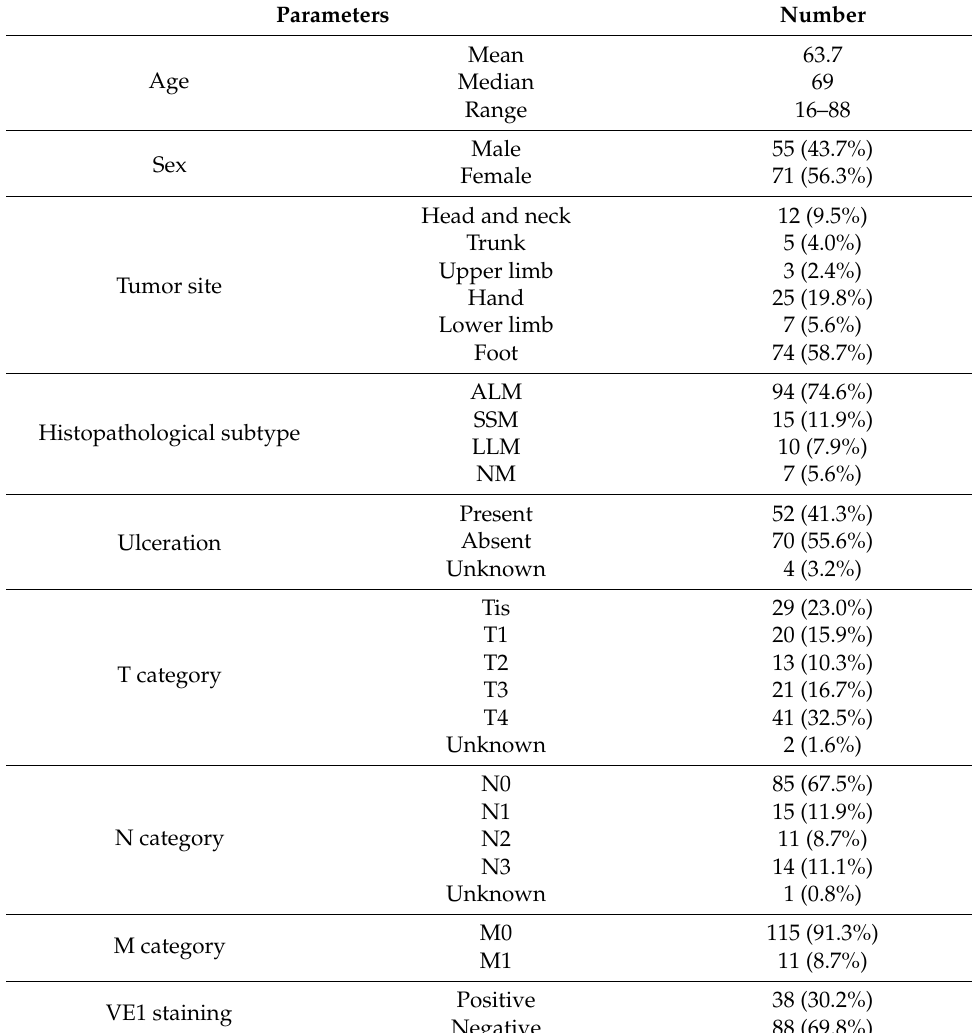
Table 1. Basic demographic and clinical characteristic data of all 126 patients with primary malignant